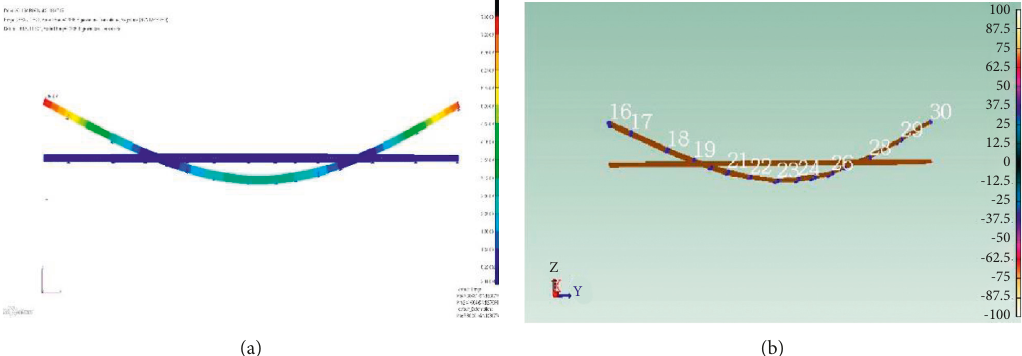
Figure 14: Vertical bending modal shape (2 nodes), design draft loading condition. (a) Numerical prediction. (b) Measurement results.